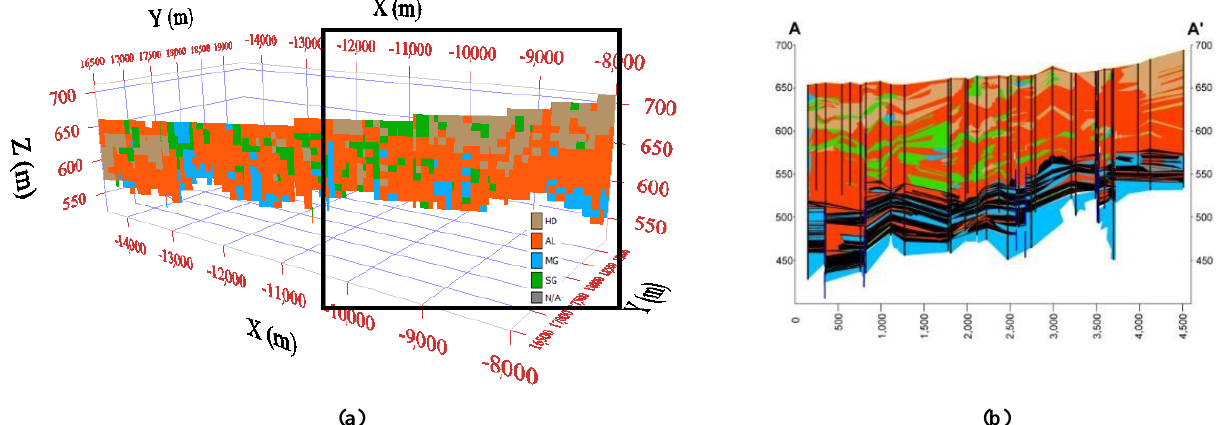
Figure 12. Comparison between ( a ) a realization of the model and ( b ) reality in Section A – A ’ . The bold frame shows the model area that corresponds to the real image. In addition, note that the model does not include the lignite beds shown in black color and their interburden and underburden waste layers on Section A –A’ .